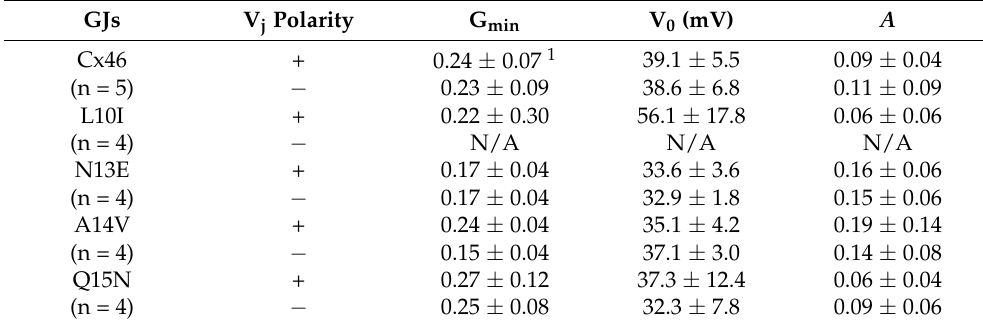
Table 1. Boltzmann fitting parameters for the GJs of Cx46 and its